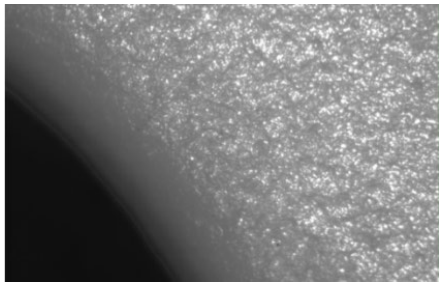
Figure 5. Microscopic analysis of injected parts.